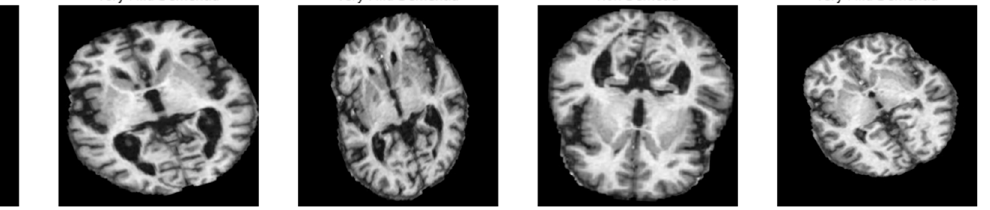
Figure 3. A visual example of the data augmentation technique applied to MRI image.